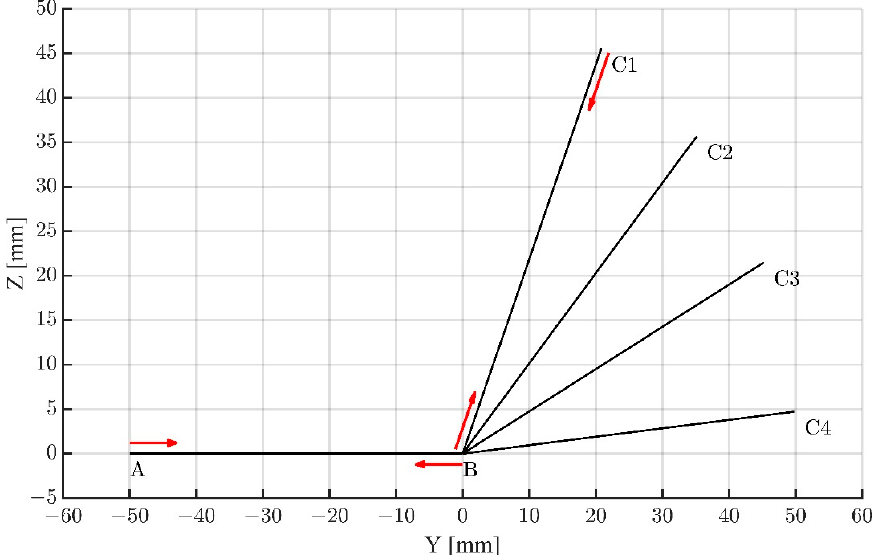
Figure 2. The ‘Fan’ testing toolpath. The path consists of four angles ∠ ABC i . The sizes of these angles are 110 ◦ , 130 ◦ , 150 ◦ , and 170 ◦ . The traversal of the toolpath was defined as follows (see the red arrows): The tool started at point A, moved to point C1 through point B, and then returned to point A through point B. The tool then traversed angles ∠ ABC 2 through ∠ ABC 4 in an analogous way (the traversal of angle ∠ ABC 1 including the return to point A is indicated by red